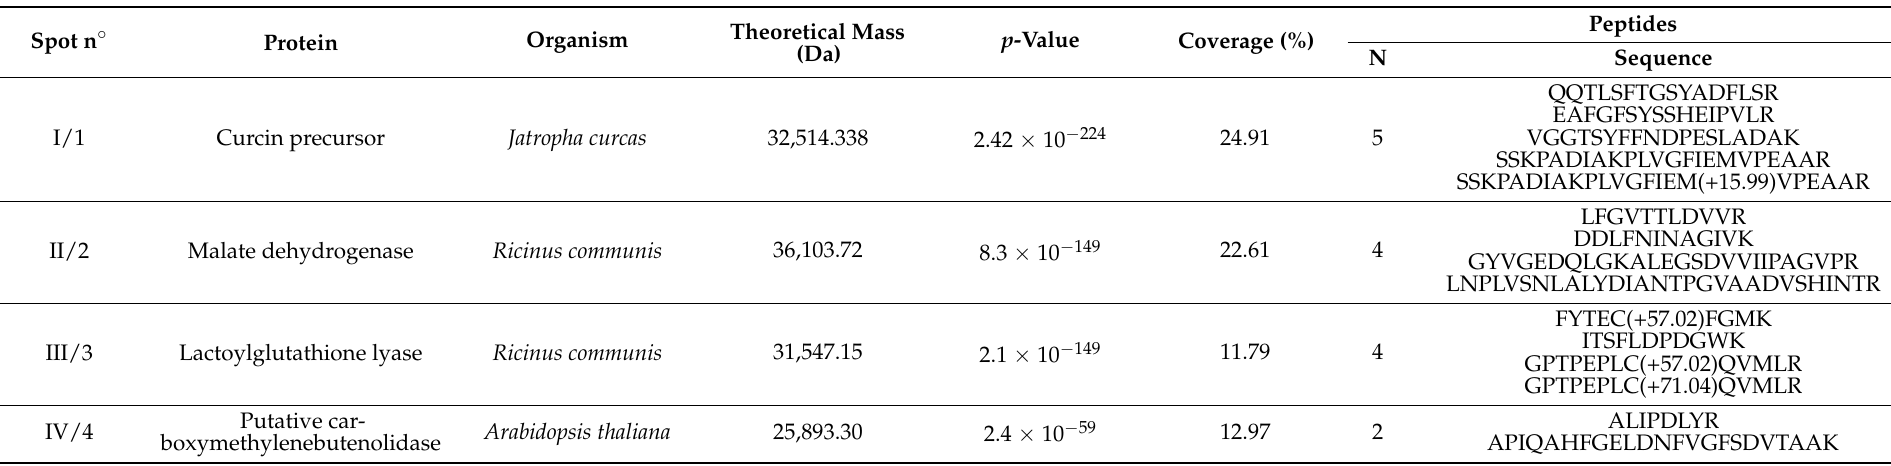
Table 2. Protein identification after mass spectrometry analysis. Spots are numbered accordingly to Figures 2 and